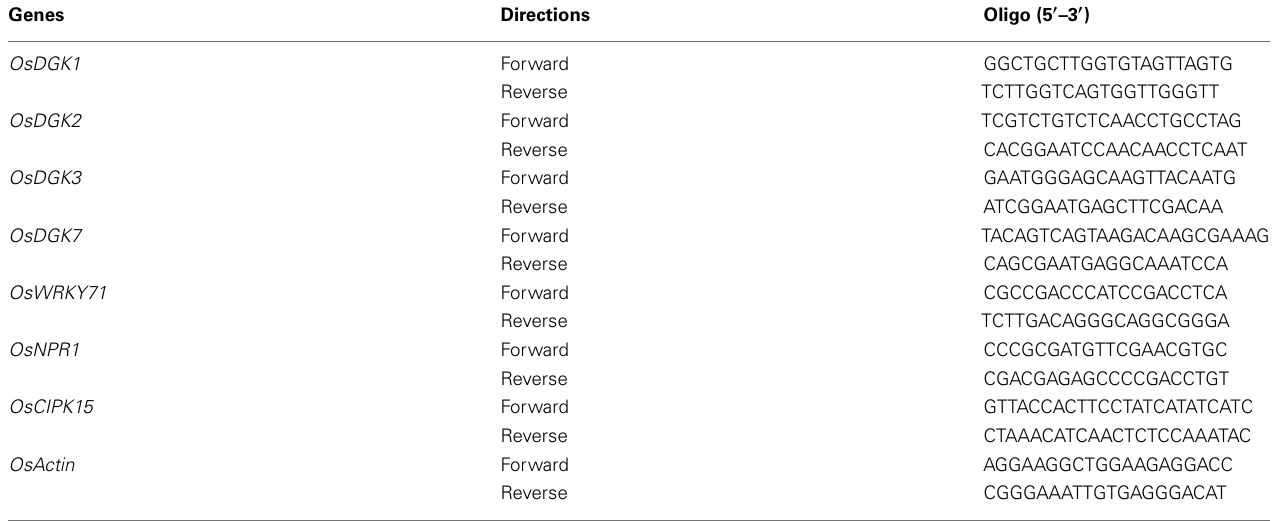
TableA3 | List of oligos used for real-time PCR analysis. Genes